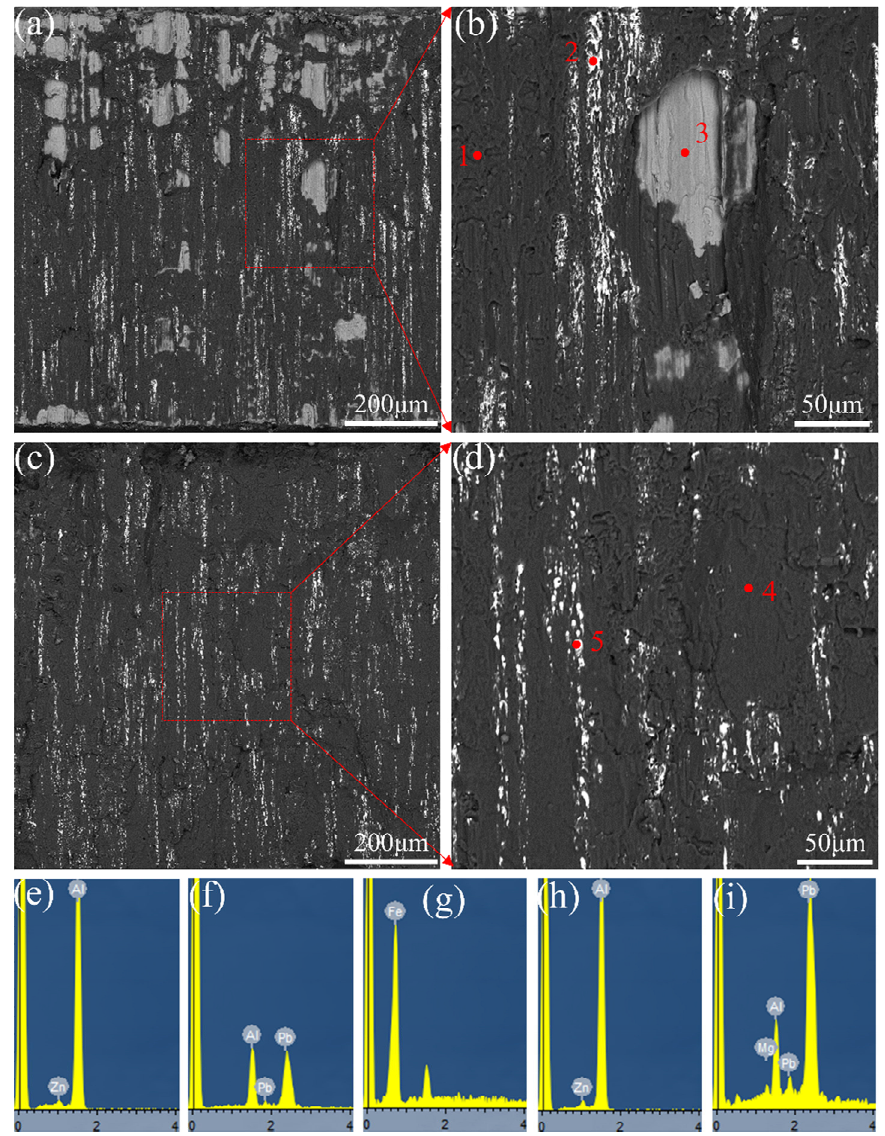
Figure 11. Fractured surfaces of steel layers and corresponding EDS point energy spectrum of Al/steel clad sheets: ( a , b , e – g , respectively) initial sample and ( c , d , h , i , respectively) aged sample.